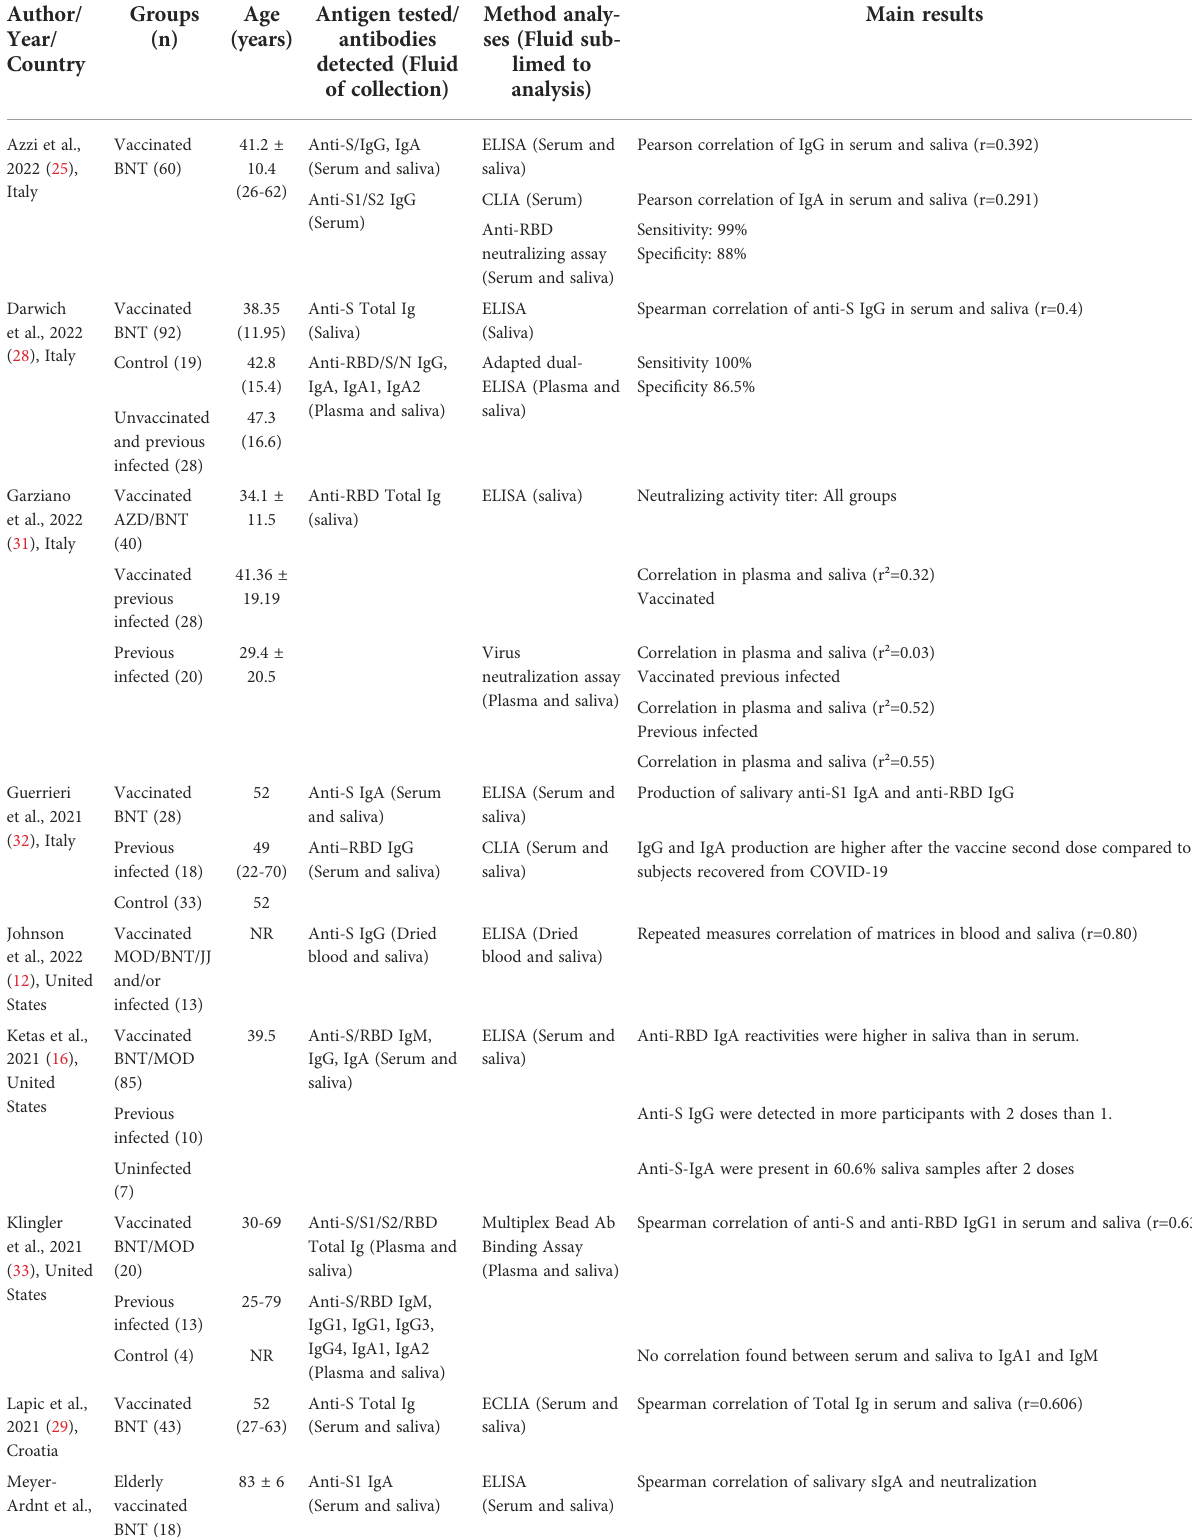
TABLE 1 Summary of overall descriptive characteristics of included studies (n =